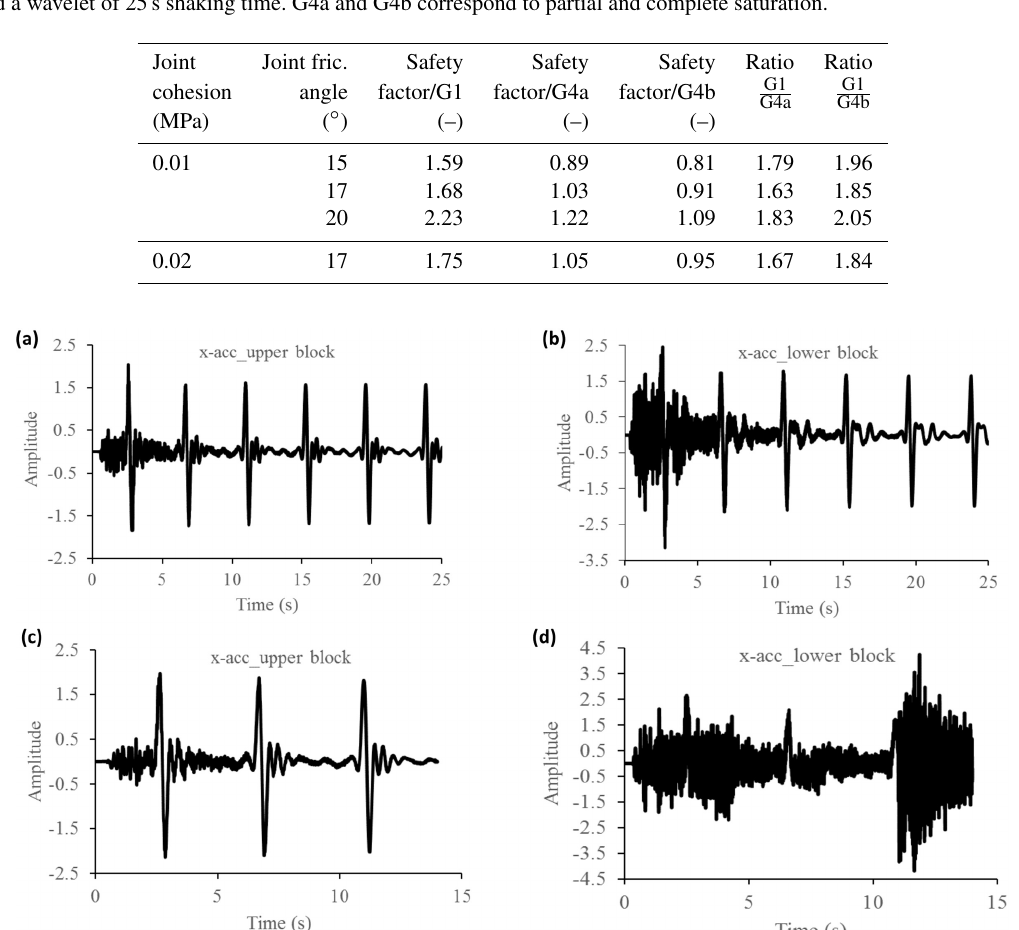
Figure 11. Actual x acceleration for 25s (a, b) and 14s (c, d) computational time.